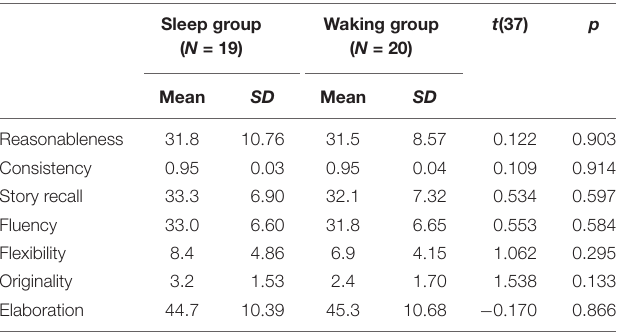
TABLE 2 | Effects of sleep on problem solving.